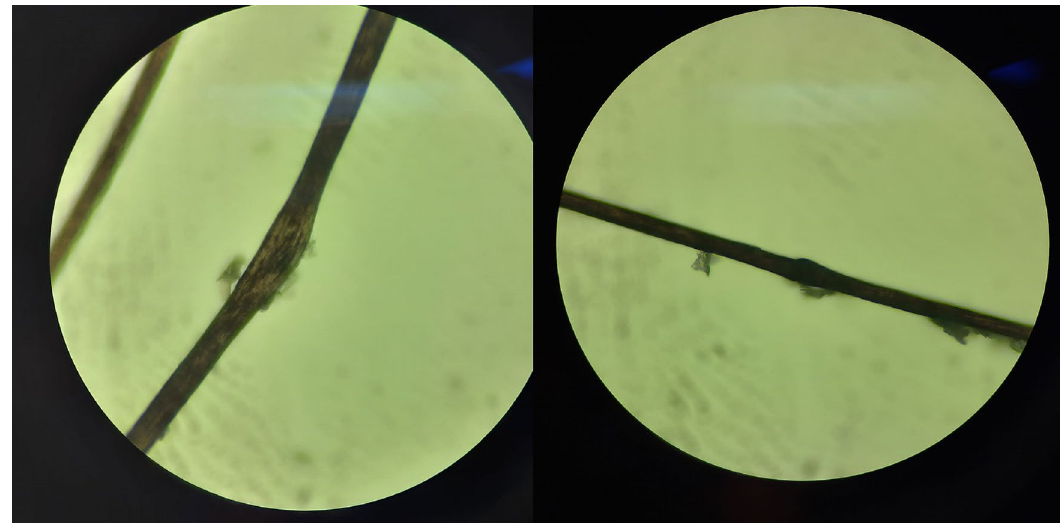
Fig. 1 Bamboo stick hair: appearance in a hair sample from the newborn